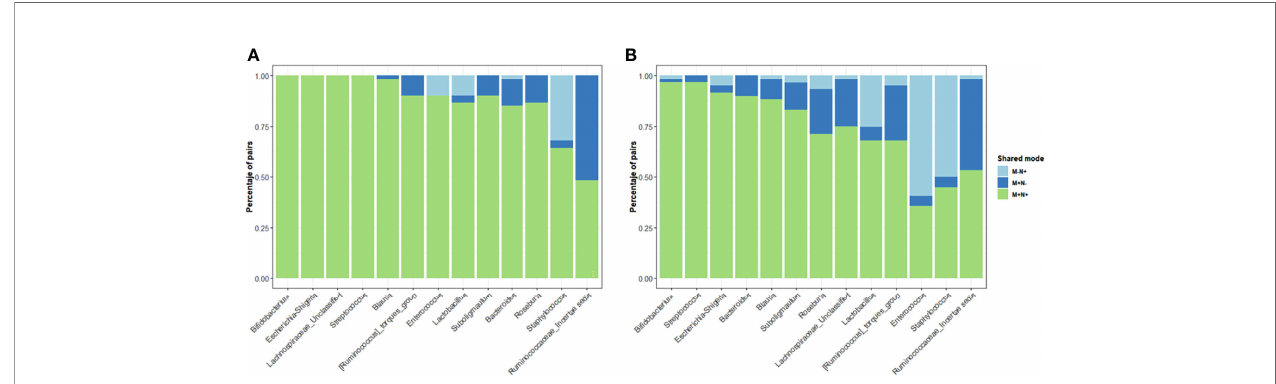
FIGURE 4 | Distribution of the shared genera between mother-neonate dyads Only those genera from both maternal and neonatal core were included in the study of shared genera in China (A) and Spain (B) populations. Three modes of genera presences/absence were established: M+N+ (genera present in both mother and infant of each dyad), M+N- and M-N+ (genera present in only mother or only neonate, respectively). The percentage of dyads in each share mode were calculated for each core